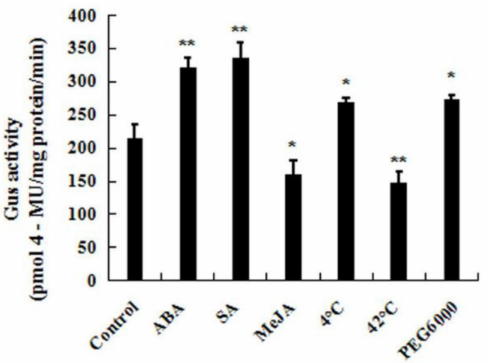
Figure 7. CpWRKY71 promoter activity in response to abiotic stress and hormone treatments. Ten-day-old T3 homozygous Arabidopsis transgenic seedlings were treated with 50 µ M ABA, 100 µ M SA, 100 µ M MeJA, cold stress at 4 ◦ C and heat stress at 42 ◦ C for 6 h, or 15% PEG6000 for 12 h. The plants grown under normal conditions were used as controls. Data represent the mean of three biological repeats ± SD. Error bars indicate standard deviation. Asterisks denote statistically significant di ff erences compared with control, * p < 0.05, ** p <